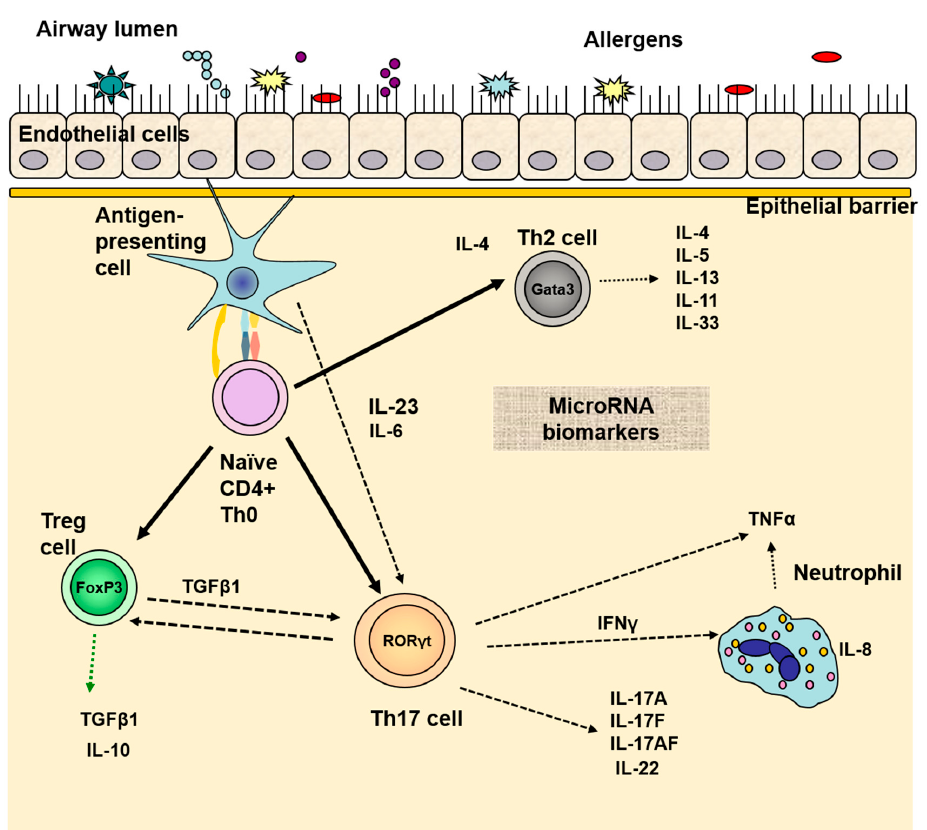
Figure 1. Immunological interactions in the inflamed mucosa in the concept of united airway disease. Naïve T cells differentiate either into Th2, Tregs, or Th17 cells. By secreting a distinct array of cytokines, Th17, Th2, and Treg cells connect innate and adaptive immune responses in the airway mucosa, especially during mucosal inflammation. Balance of Th17/Tegs is needed to maintain the immune homeostasis in the mucosa and to resolve the inflammation. Note: allergens are presented as different shaped objects in the airway